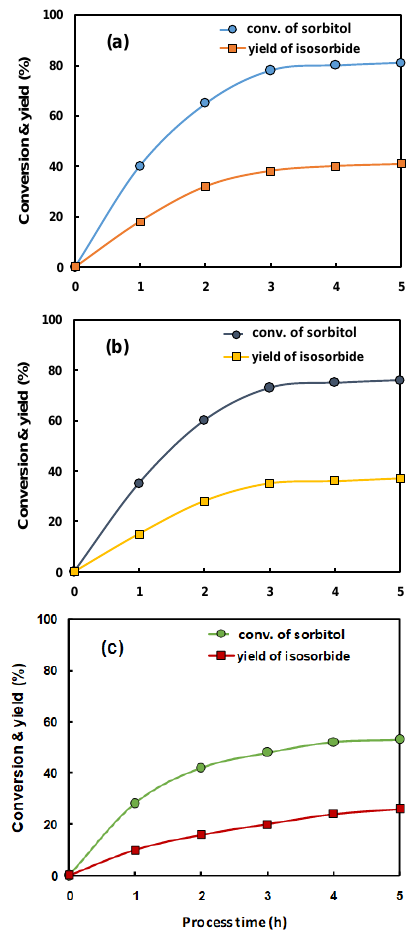
Figure 8. Conversion of sorbitol and isosorbide yield as a function of process time on the ( a ) BEA zeolite, ( b ) Amberlyst 35, and ( c ) FAU zeolite.